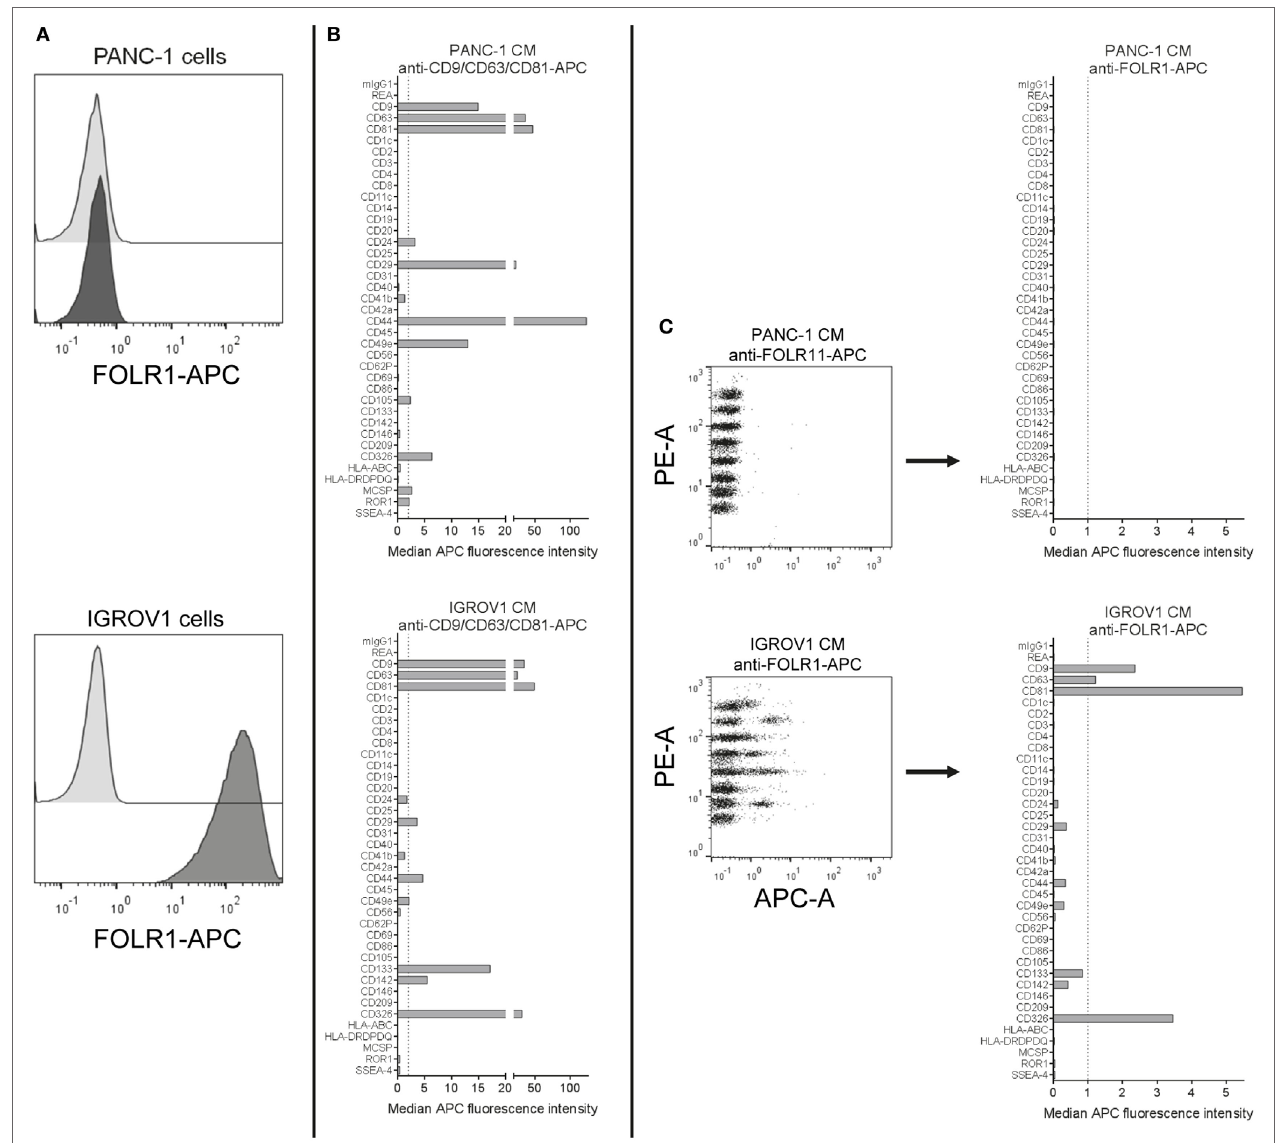
FigUre 7 | Detection of FOLR1 on human cell culture-derived extracellular vesicles. (a) PANC-1 and IGROV1 cells stained with APC-conjugated anti-FOLR1 antibodies (dark gray) compared to respective unstained controls (light gray). (B) Conditioned medium (CM) from PANC-1 and IGROV1 cells analyzed in the multiplex bead-based flow cytometric assay, stained with pan tetraspanin-APC detection cocktail. (c) The same samples as in (B) stained with APC-conjugated anti-FOLR1 antibodies. The figure shows representative data from one out of at least two independent experiments. See Table S2 in Supplementary Material for further